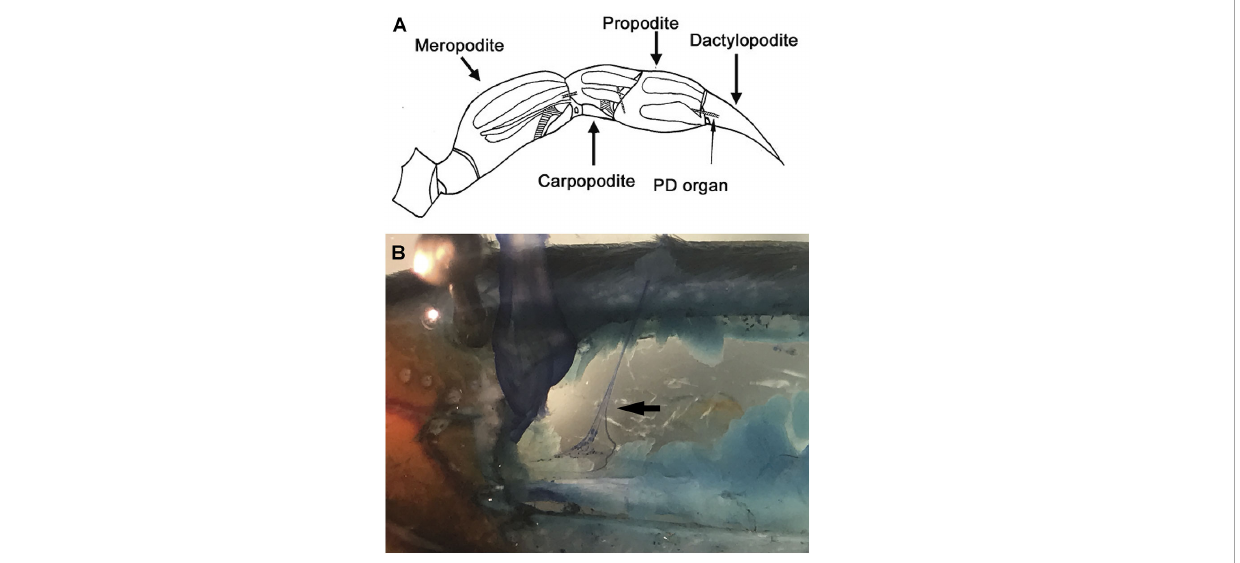
FIGURE 7 Crab chordotonal organ. (A) : Drawing of the fi rst walking leg of a crab showing the anatomical location of chordotonal organs (hatched regions). PD organ spans the most distal joint in the limb between the propodite and dactylopodite. (B) : Innervation of chordotonal organs. Image of a dissected fi rst walking leg of a blue crab ( Callinectes sapidus ). PD nerve dissected away from the main leg nerve (arrow). The individual neurons stained with methylene blue are visible. (PD: Propodite-dactylopodite chordotonal organ) (Image courtesy of Dr. Robin L. Cooper